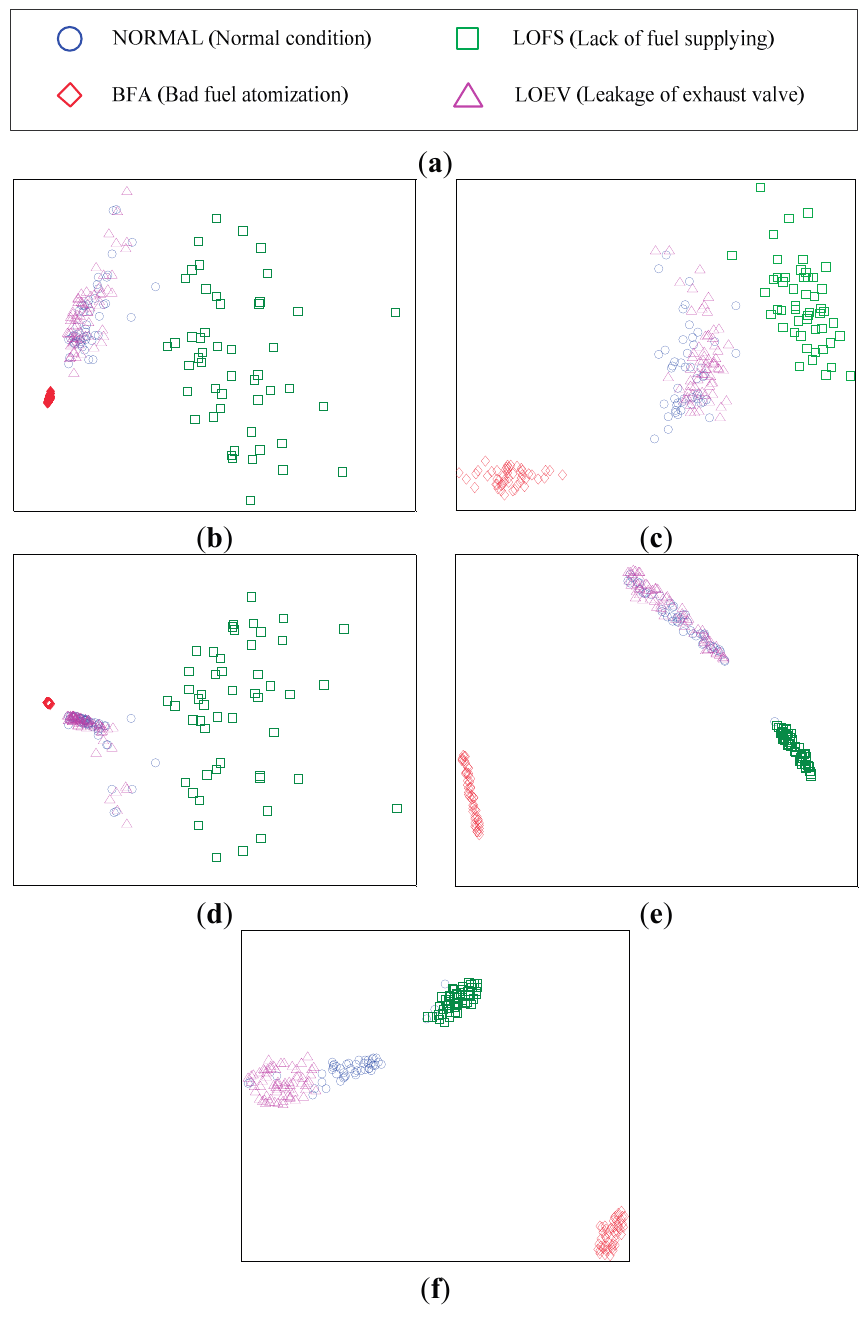
Figure 9. ( a ) Symbols description; ( b ) PCA; ( c ) LDA; ( d ) ISOMAP; ( e ) t-SNE; ( f )